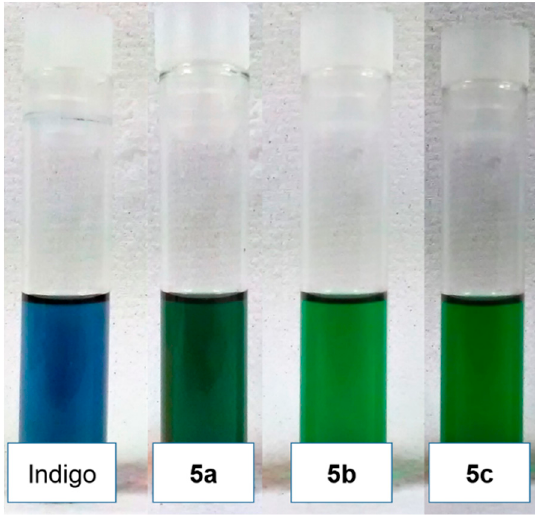
Figure 6. Solutions of dyes 5a (2.3 × 10 − 4 M), 5b (3.5 × 10 − 4 M) and 5c (7.8 × 10 − 5 M) in CH 2 Cl 2 , in comparison with indigo suspension in CHCl 3 (0,17 mg/mL ≈ 6.5 × 10 − 4 M).